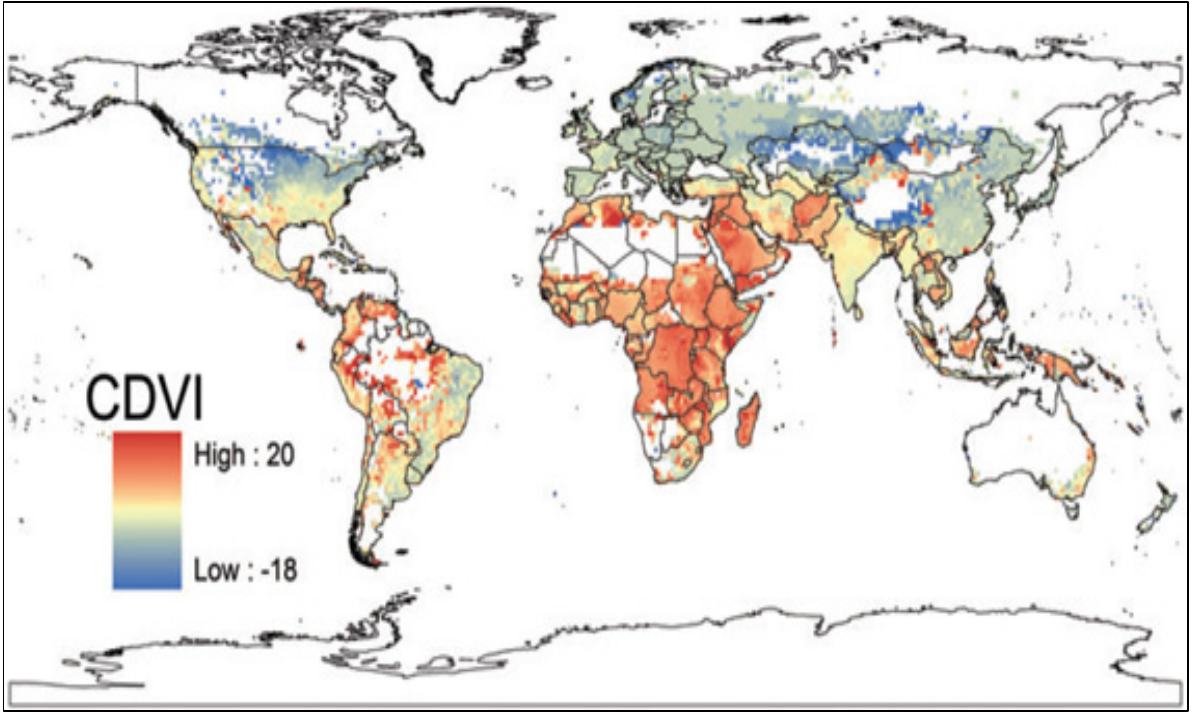
Figure 3: Who loses from climate change? Climate Demography Vulnerability